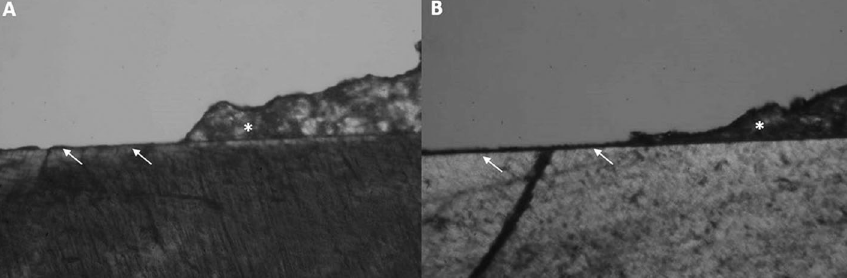
varnish; (B) and TiF solution groups. ( → ) Enamel 4 4